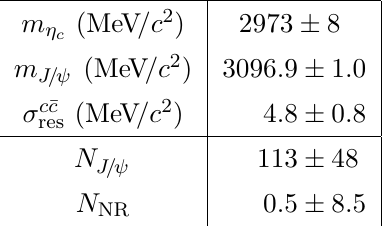
Table 3 . Results of the (cid:12)t to the p (cid:22) p invariant-mass spectra weighted for B 0